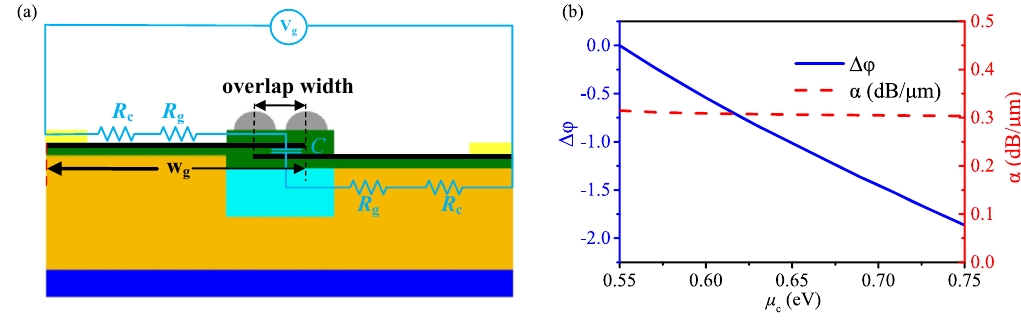
Figure 9: Improved GPM with reduced overlap width of the graphene capacitor.